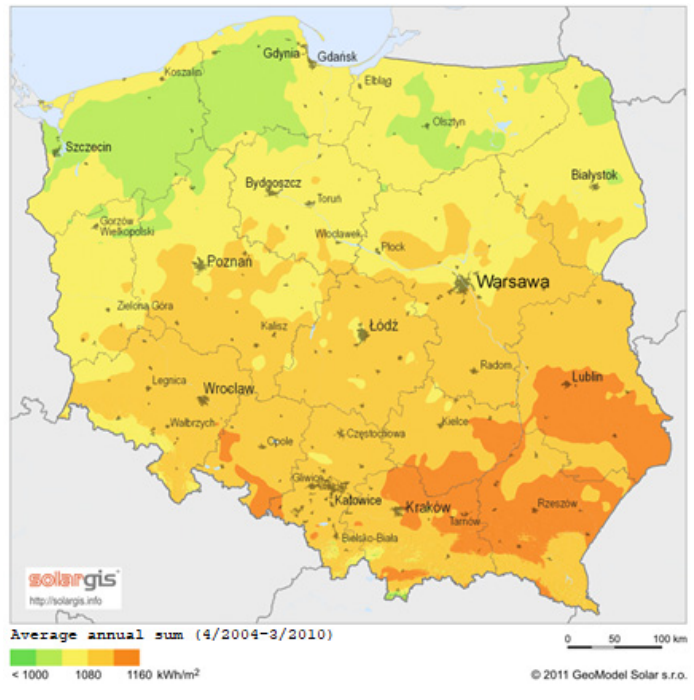
Figure 5. The horizontal-plane insolation in Poland [38]. The research focused on determining the angle of inclination and the type of substrate (different albedo coefficients) that influences the bifacial photovoltaic modules’ operation. The tested angles were in the 15–90° range with 15° increments. The substrates used for measurements were grass, white substrate, and foil, which well reflects solar irradiance. Grass’ reflectance is in the range between 0.15 and 0.26 [39]. The white material imitates concrete or white sand, with the respective albedo of 0.2–0.4 and 0.6 [39]. The foil used for tests was a thin sheet of metallized plastic, which has a high radiation reflectance, ranging from 0.8 to 0.9. Figure 6 demonstrates the module inclinations (selected angles). Figure 6a presents the test object on a grassy substrate, and Figure 6b shows the system with the under-mod- ule surface covered with a white substrate; Figure 6c shows a foil substrate. ( a ) ( c ) Figure 6. The measurement stands for tested variants: ( a ) the measurement for 15° angle with grass substrate; ( b ) measurement for 75° angle with a white substrate; ( c ) the measurement for 45° angle with a substrate composed of foil. When determining the bifacial module parameters, assume that the short-circuit cur- rent of the front and rear side of the module depends linearly on the irradiance reaching